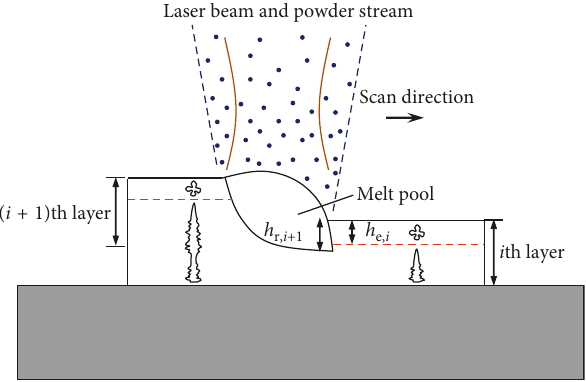
Figure 16: Epitaxial growth in multilayer laser